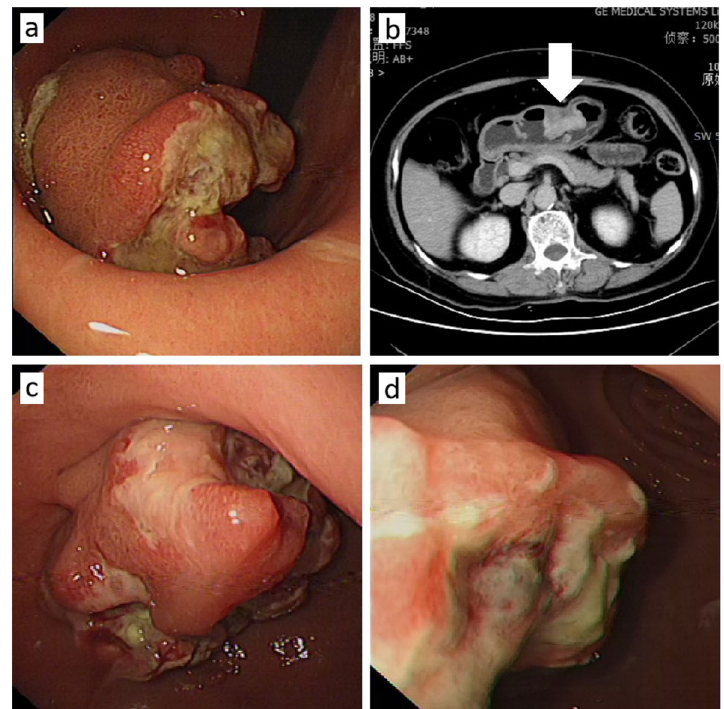
Fig. 1 Endoscopy and computed tomography (CT) findings. a Endoscopy at the patient’s initial visit reveals a mass measuring 2.5 3.0 cm at the × junction of the lesser curvature and gastric antrum. The mass has uneven surface mucosa and a base covered with a coating, with hard and brittle tissue that bleeds easily. b Enhanced CT of the upper abdomen shows limited thickening of the gastric wall in the gastric antrum and enlarged perigastric lymph nodes. c and d Endoscopy at 2 months after chemotherapy shows that the mass at the junction of the lesser curvature and gastric antrum is unchanged. It is of the same size (2.5 3.0 cm), and shows a central ulcer and a base covered with a coating, with hard and brittle × tissue that bleeds